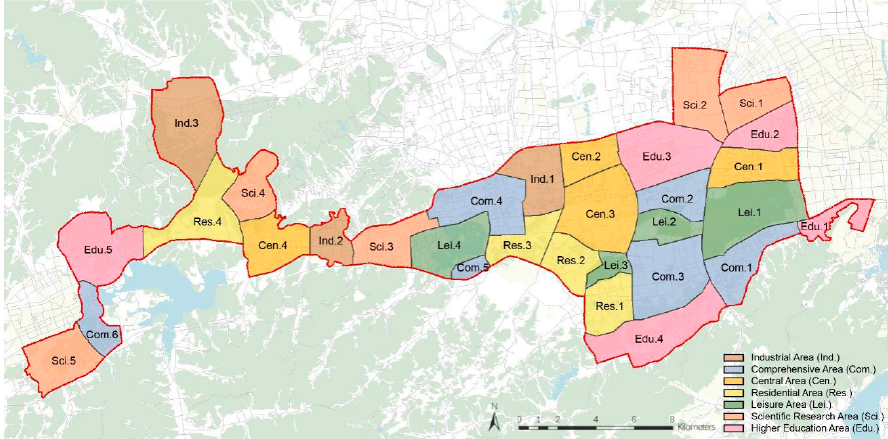
Figure 2. Distribution of the Hi-Tech Corridor’s functional areas. Table 1. List of functional areas.